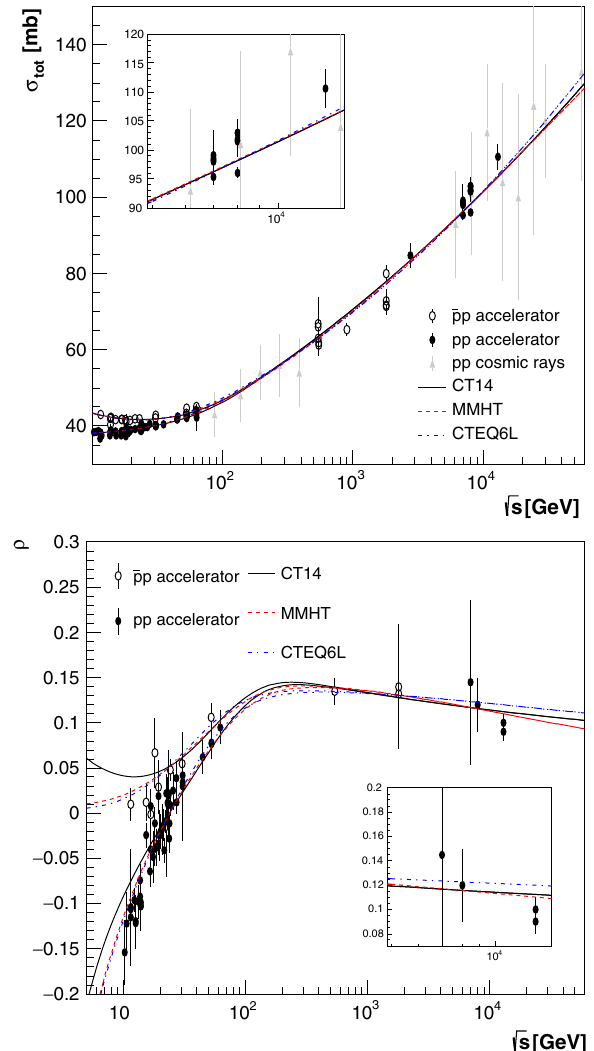
Fig. 5 Global 1 σ -fit to σ pp parameters and quality estimators are given in Table